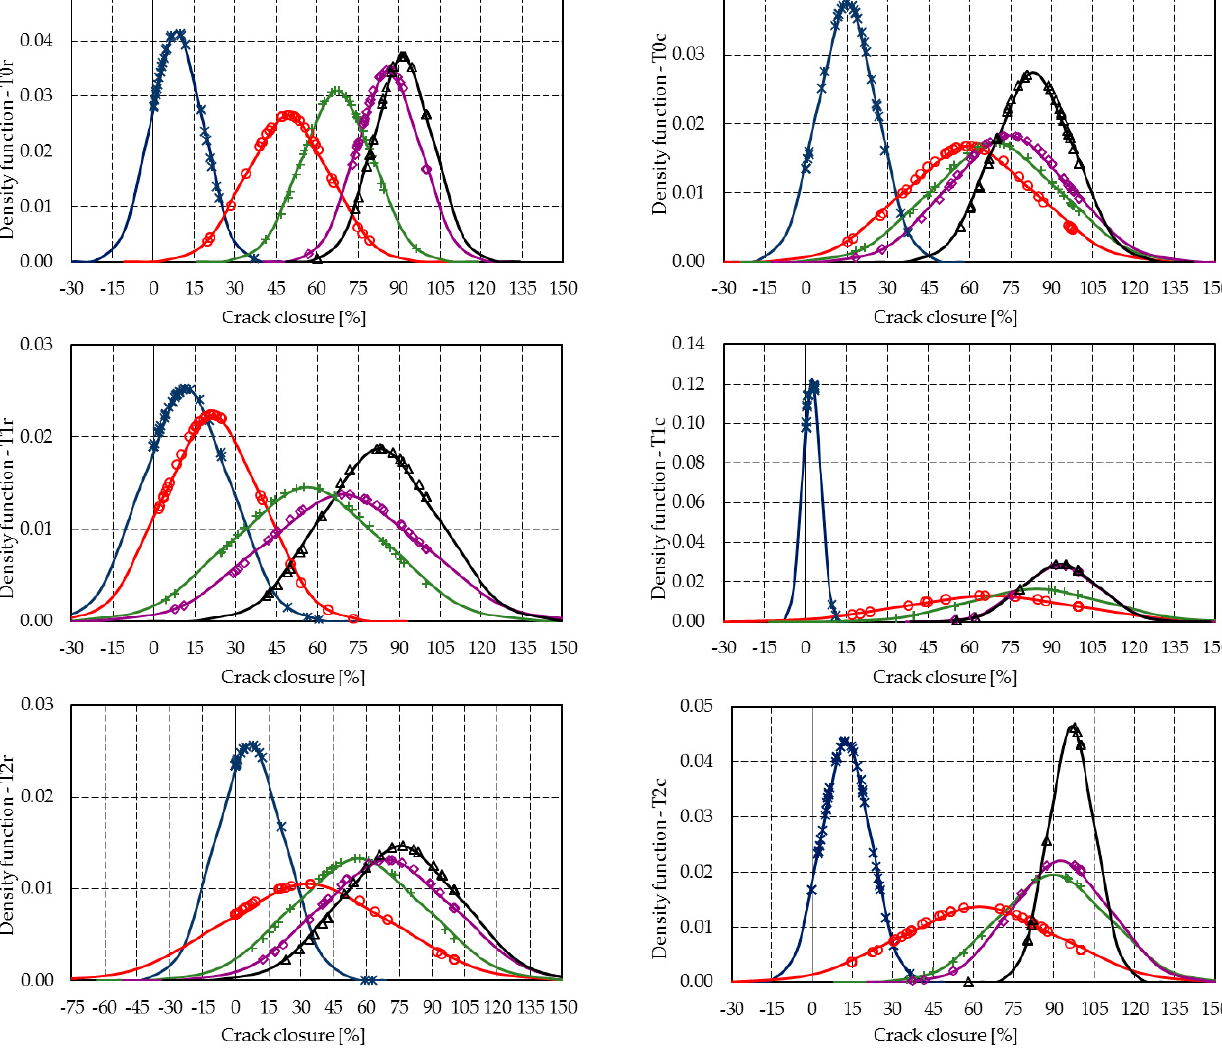
( b ) Figure 9. Gaussian distributions of the crack closure: ( a ) T0r–T3r; ( b ) T0c–T3c.